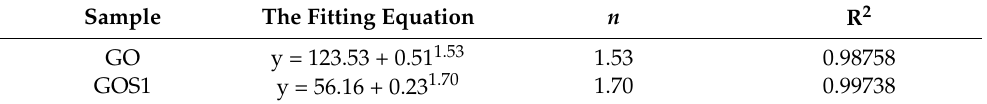
Figure 13. SEM pictures of cement-based materials cured for 28 d: ( a , c , d ) Control. ( b , e , f ) GOS1. Table 6. H-B fitting curve equations of cement-based materials with the same GO and GOS